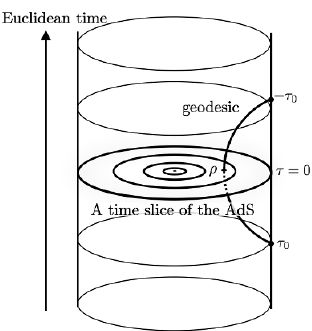
Figure 1 . The bulk position (cid:26) can be obtained as an intersection of the timeslice (cid:28) = 0 and a geodesic which connects the boundary points ( (cid:30); (cid:28) 0 ) and ( (cid:30); (cid:0) (cid:28) 0